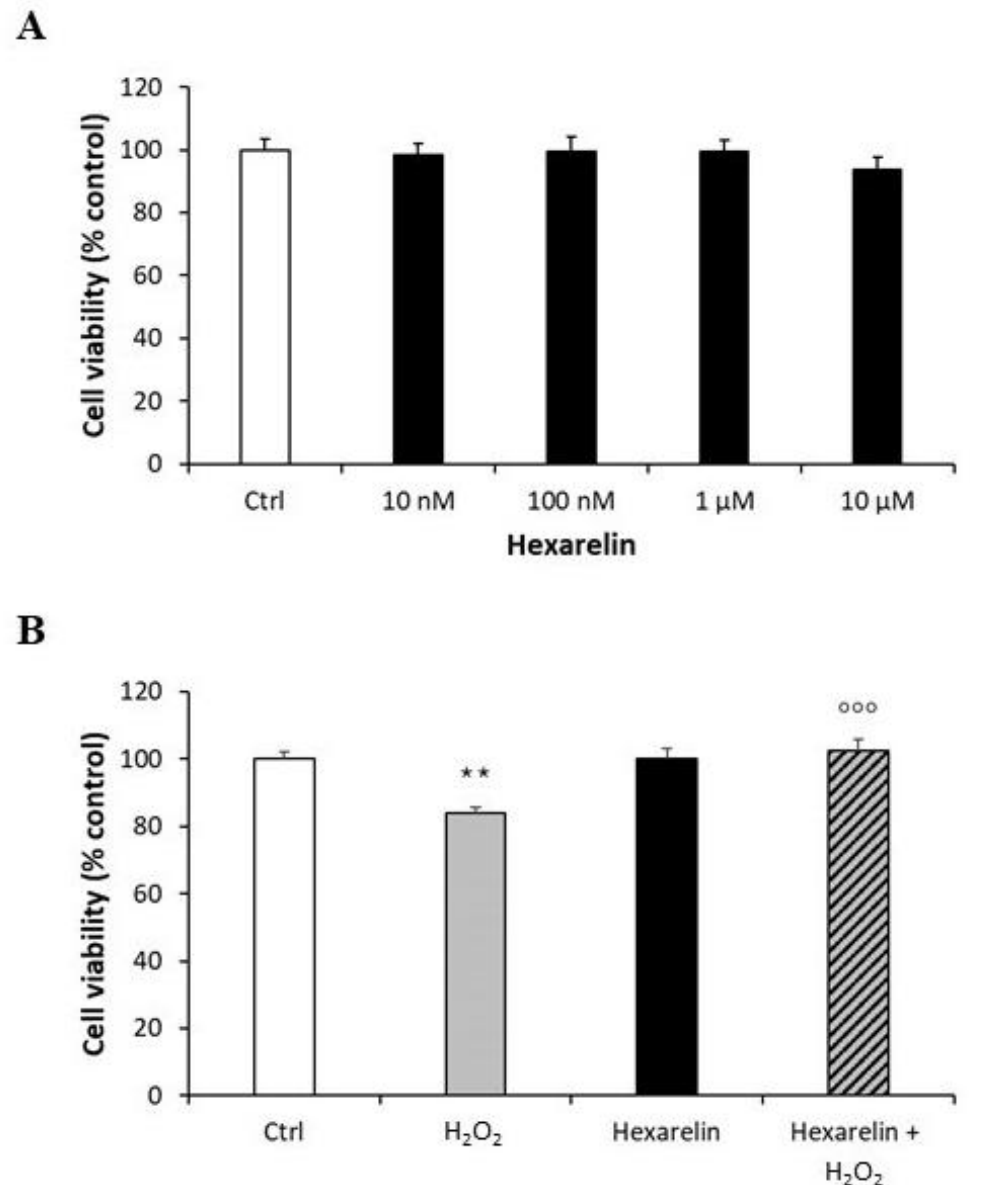
Figure 2. Protective action of hexarelin in Neuro2A cells. ( A ) Neuro-2A cells were treated for 24 h with different concentrations of hexarelin (10 nM, 100 nM, 1 µ M, and 10 µ M), ( B ) with or without hexarelin (1 µ M) and H 2 O 2 (100 µ M) and assessed for MTT assay. All assays were performed in at least three independent experiments ( n = 21). Statistical significance: ** p < 0.01 vs. CTRL; ◦◦◦ p < 0.001 vs. H 2 O 2 .